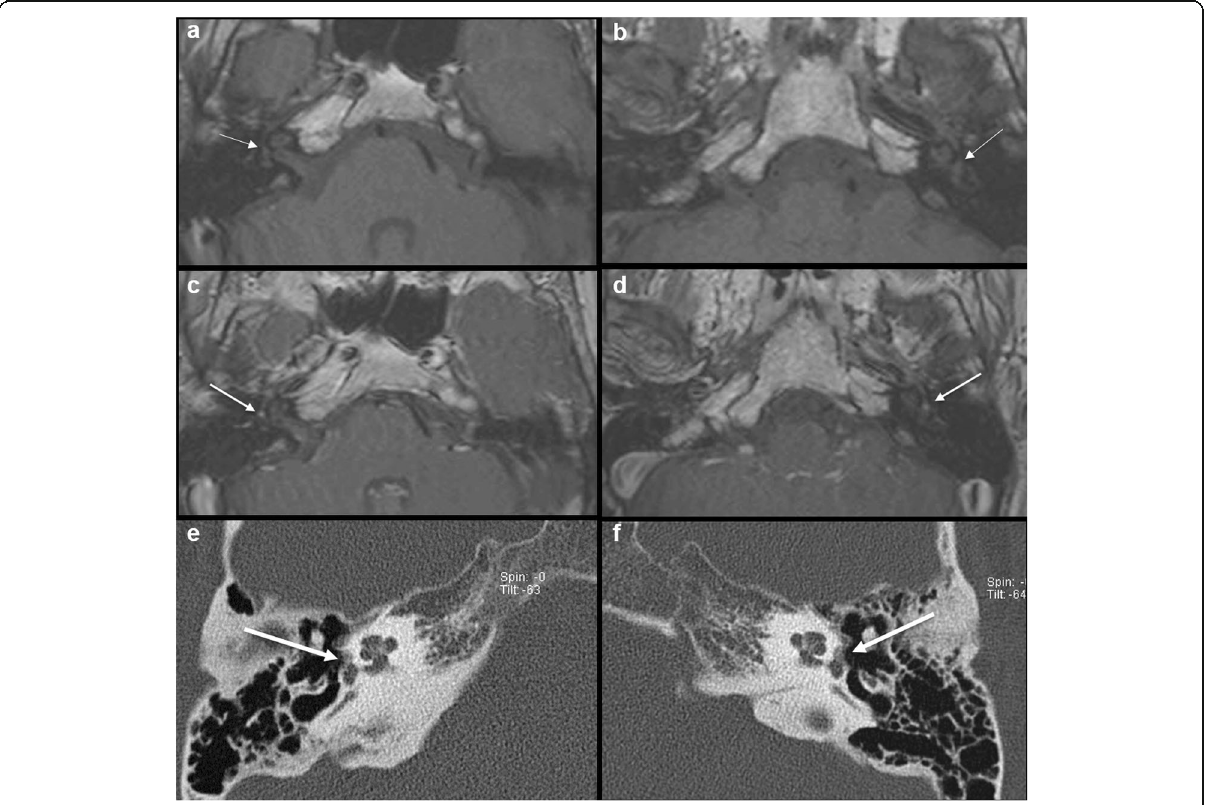
Fig. 2 A 28-year-old male patient with left-sided SNHL (case 2). This was the case where otosclerosis was missed on first read MRI. Retrospective evaluation of axial T1W MR images ( a , b ) shows very subtle intermediate T1 signal in bilateral FA regions (arrows). Contrast-enhanced axial T1W images ( c , d ) show subtle focal post-contrast enhancement in bilateral FA regions (arrows). Axial HRCT images ( e , f ) show bilateral fenestral otosclerotic plaques (arrows). There was no pericochlear disease seen on